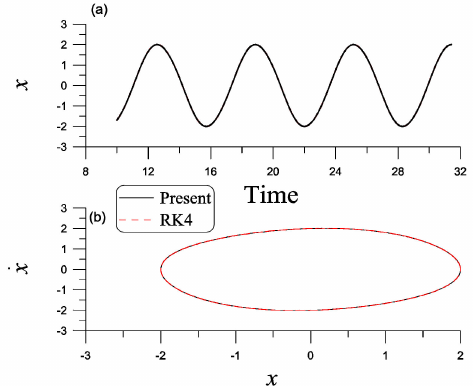
Figure 3. For the van der Pol equation with A = 2, comparing the exact solution obtained by the RK4 and the solution obtained by the present method: ( a ) time histories of displacement and ( b ) periodic . (cid:0) (cid:1) x , x orbits in the phase plane